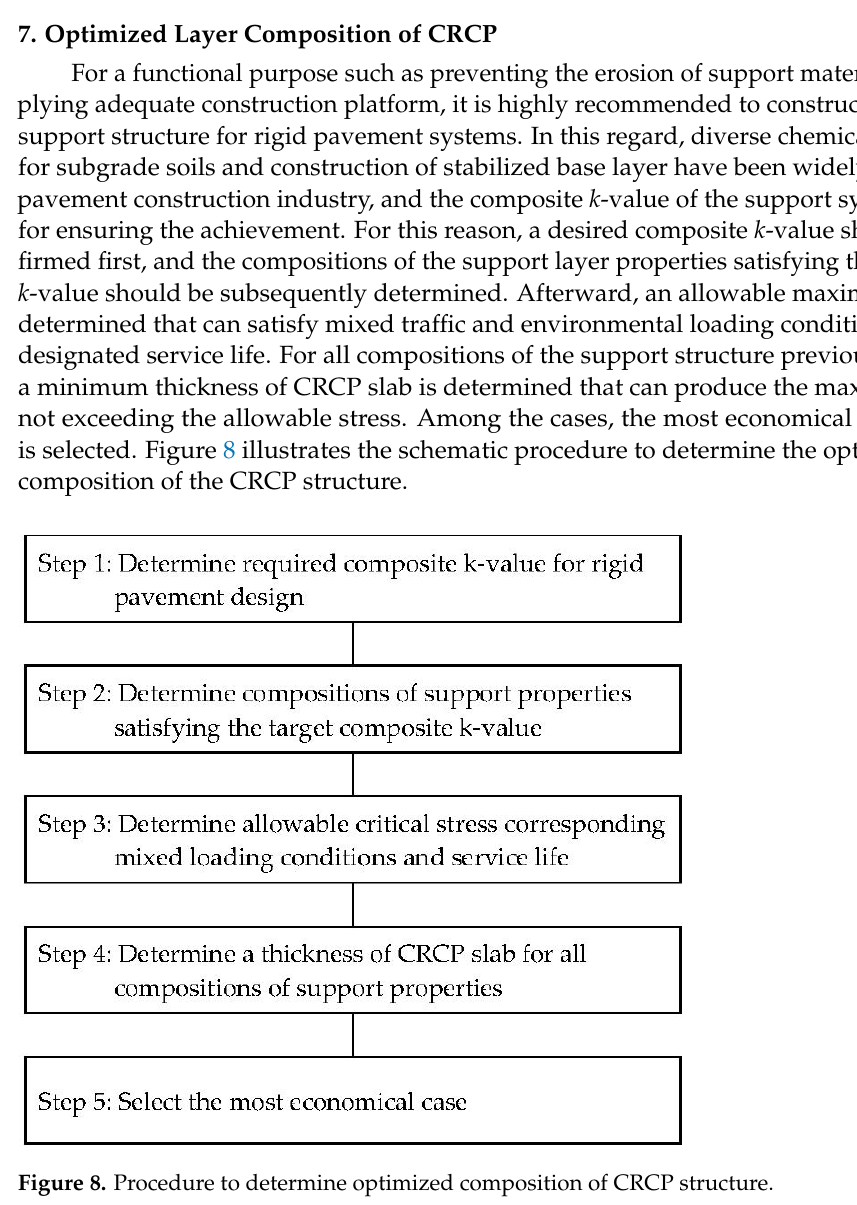
Table 12. Regression coefficients for the maximum stress under temperature, vehicle wheel, and combined loading conditions.